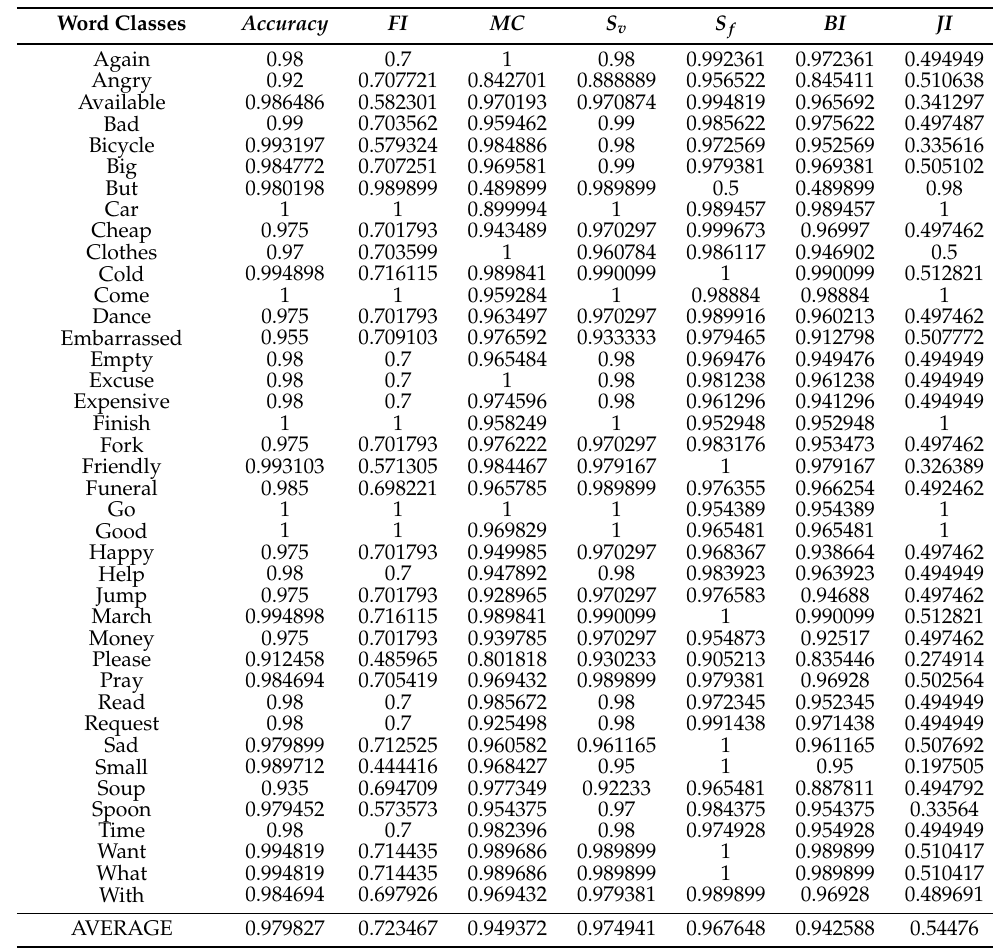
Figure 9. Training performance of Deep BiLSTM network on Model-2. Table 8. Performance evaluation of multi-stack deep BiLSTM network using leave-one-subject-out